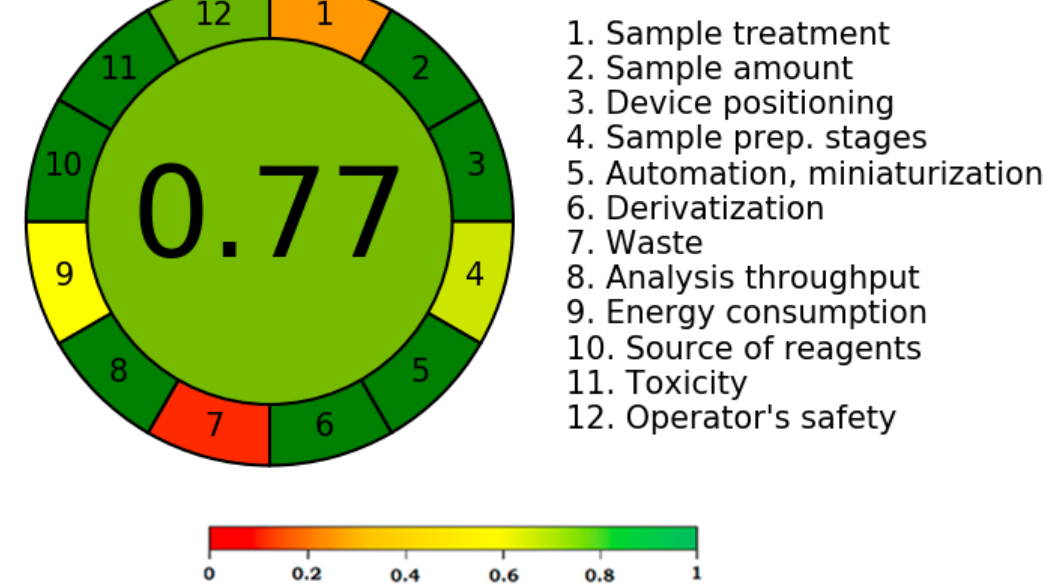
Figure 6. The representative pictogram for AGREE scale for the proposed HPTLC strategy derived using AGREE calculator.